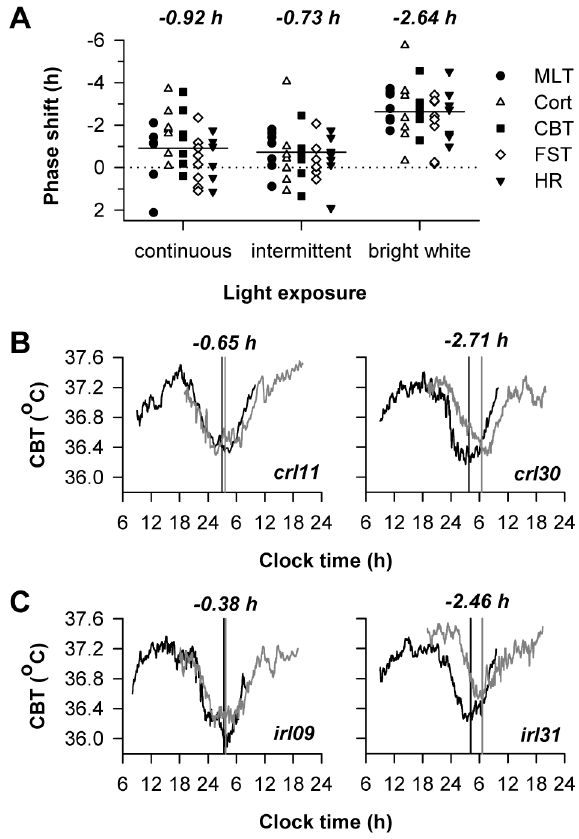
Figure 3. Circadian phase shift responses were similar for exposure to continuous versus intermittent red light. ( A ) Circadian responses are shown for individual subjects exposed to 6 h of continuous red light, intermittent red light and darkness, or bright white light. Circadian phase shifts are shown for melatonin (MLT), cortisol (Cort), core body temperature (CBT), forehead skin temperature (FST), and heart rate (HR). By convention, negative values show phase delay shifts. Horizontal lines show the grand mean for each light exposure condition, with the corresponding values shown at the top of the plot. ( B ) Most subjects exposed to continuous red light exhibited a small resetting response (left), but one participant showed a phase delay shift comparable in magnitude to bright white light exposure (right). ( C ) Likewise, in response to intermittent red light and darkness, circadian phase measured before and after light exposure was similar in most subjects (left); however one subject showed a large phase delay shift (right). In B and C , representative subjects are shown, with the circadian rhythm of core body temperature (CBT) shown before and after exposure to light (black and gray traces, respectively). Vertical lines show the timing of the fitted minimum for the CBT rhythm. Phase shift values are shown at the top of each plot, and the corresponding subject code is shown on the bottom right. doi:10.1371/journal.pone.0096532.g003 exhibited pupillary constriction during exposure to red light (Fig. 4C–D). At the beginning of exposure to continuous red light, pupil diameter decreased to about half of the dark-adapted size and then increased gradually over time. During exposure to intermittent red light and darkness, each light pulse elicited a similar response, and pupil diameter dilated toward the dark- adapted state during intervening dark periods. In bright white light, pupillary constriction was strong and sustained, with pupil diameter decreasing to about a third of the size measured in darkness.